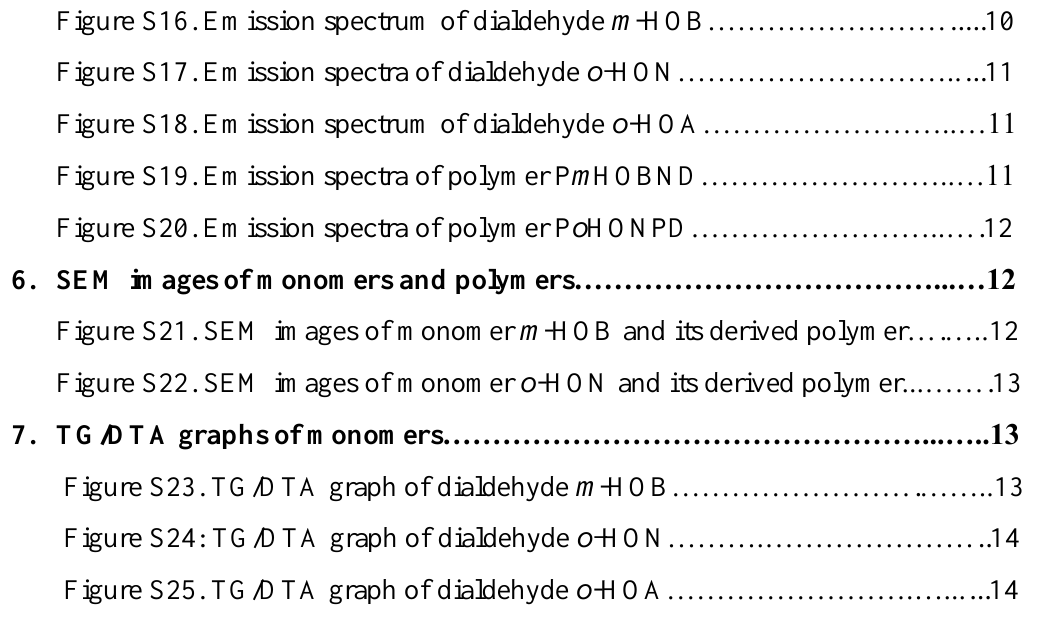
Figure S16. Emission spectrum of dialdehyde m -HOB…………………….....10 Figure S17. Emission spectra of dialdehyde o- HON……………………….....11 Figure S18. Emission spectrum of dialdehyde o -HOA……………………..…11 Figure S19. Emission spectra of polymer P m HOBND……………………..…11 Figure S20. Emission spectra of polymer P o HONPD……………………..….12 6. SEM images of monomers and polymers………………………………...…12 Figure S21. SEM images of monomer m -HOB and its derived polymer….…..12 Figure S22. SEM images of monomer o -HON and its derived polymer...…….13 7. TG/DTA graphs of monomers…………………………………………...…..13 Figure S23. TG/DTA graph of dialdehyde m -HOB…………………….……..13 Figure S24: TG/DTA graph of dialdehyde o- HON……….…………………..14 Figure S25. TG/DTA graph of dialdehyde o